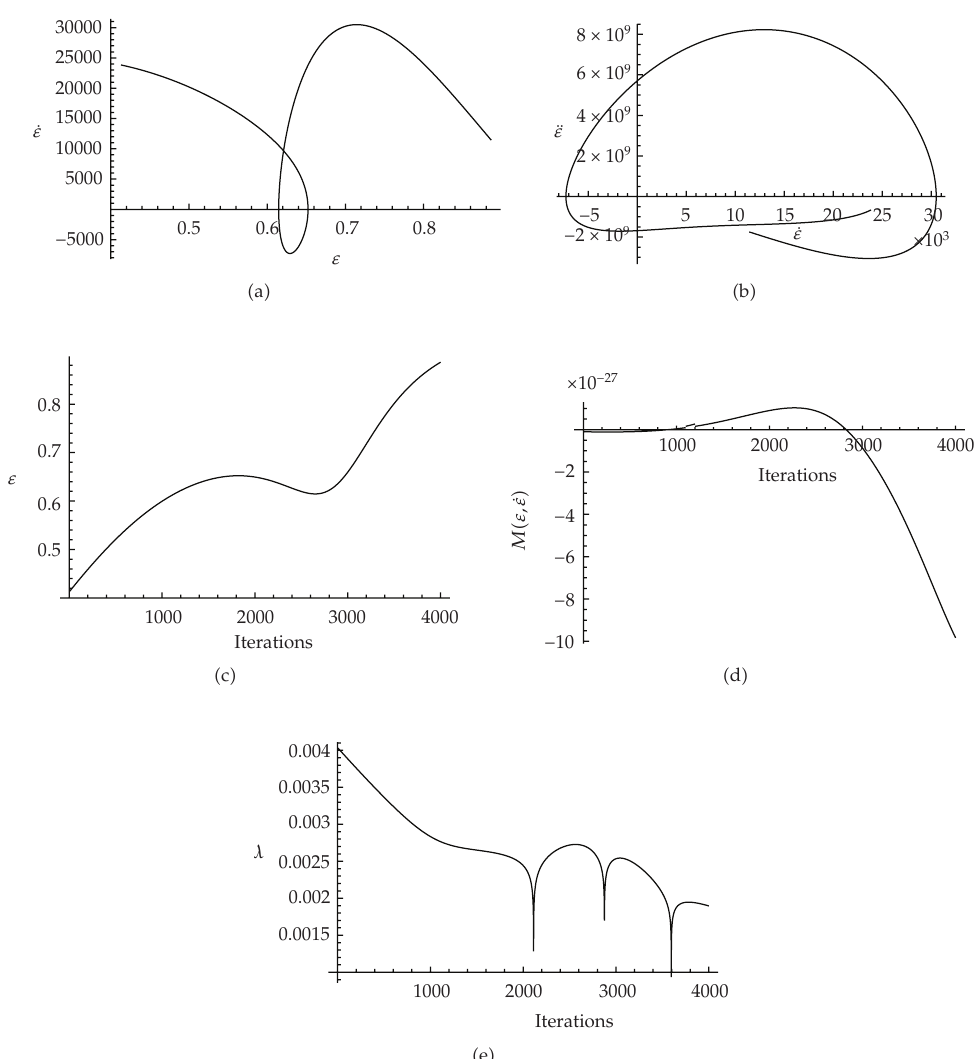
Figure 4: (cid:6) a (cid:7) and (cid:6) b (cid:7) . The ε, ˙ ε and the ˙ ε, ¨ ε graphs, respectively. One can see the loop cycle in both phase space graphs. (cid:6) c (cid:7) and (cid:6) d (cid:7) ε and the (cid:6) universal time (cid:7) e ff ective mass M (cid:6) ε, ˙ ε (cid:7) as functions of the number of iterations. One can see how ε temporarily decreases during the cycle. The e ff ective mass